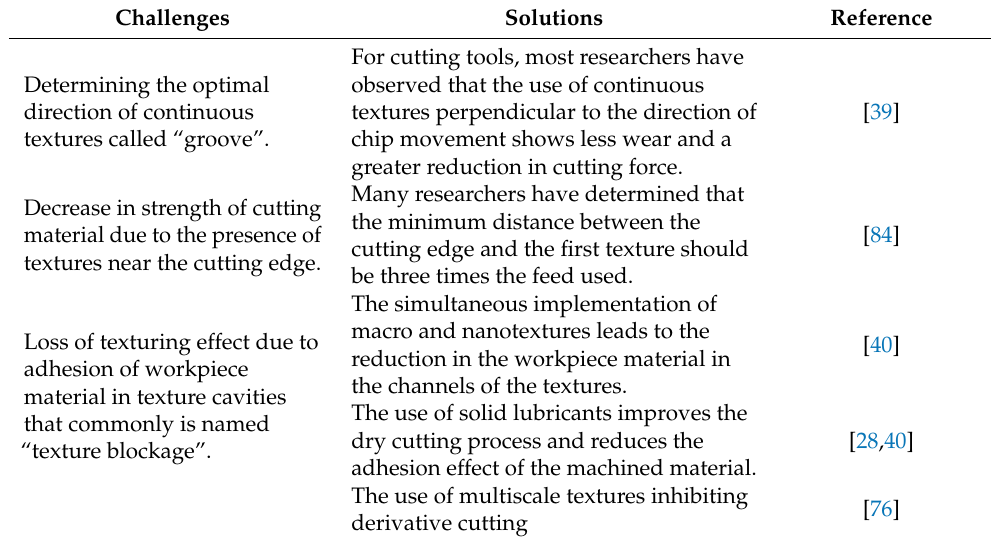
Table 2. Challenges and solutions when using surface texturing in cutting